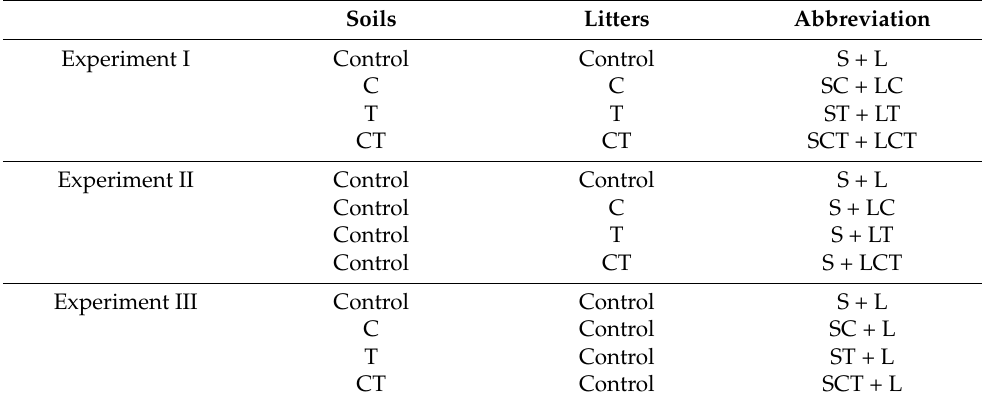
Table 1. Experimental design. Control represents the soils or litter that were collected from the ambient atmospheric CO 2 without warming; C represents the soils or litter that were collected from elevated CO 2 ; T represents the soils or litter that were collected from plant canopy warming; CT represents the soils or litter that were collected from CO 2 plus warming.